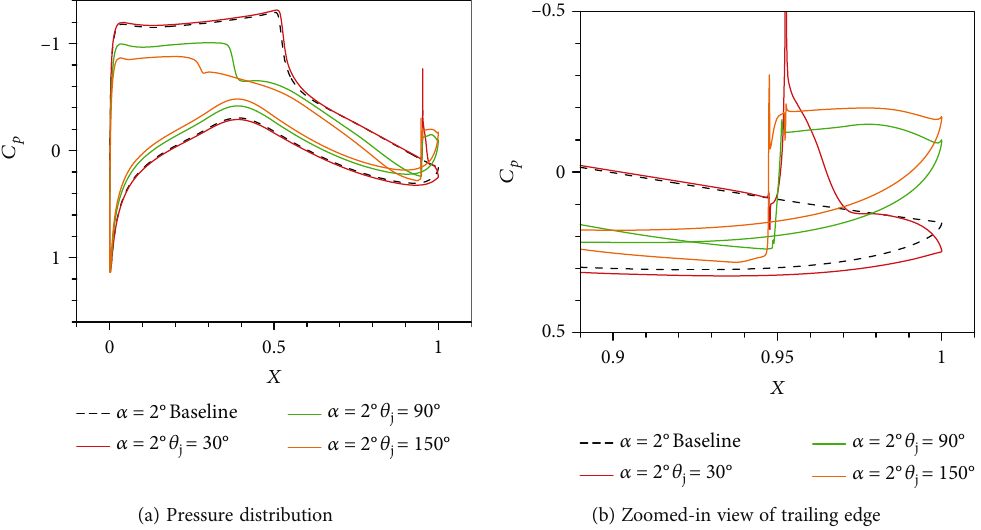
= 0 : 729 , α = 3 ° , and C ∞